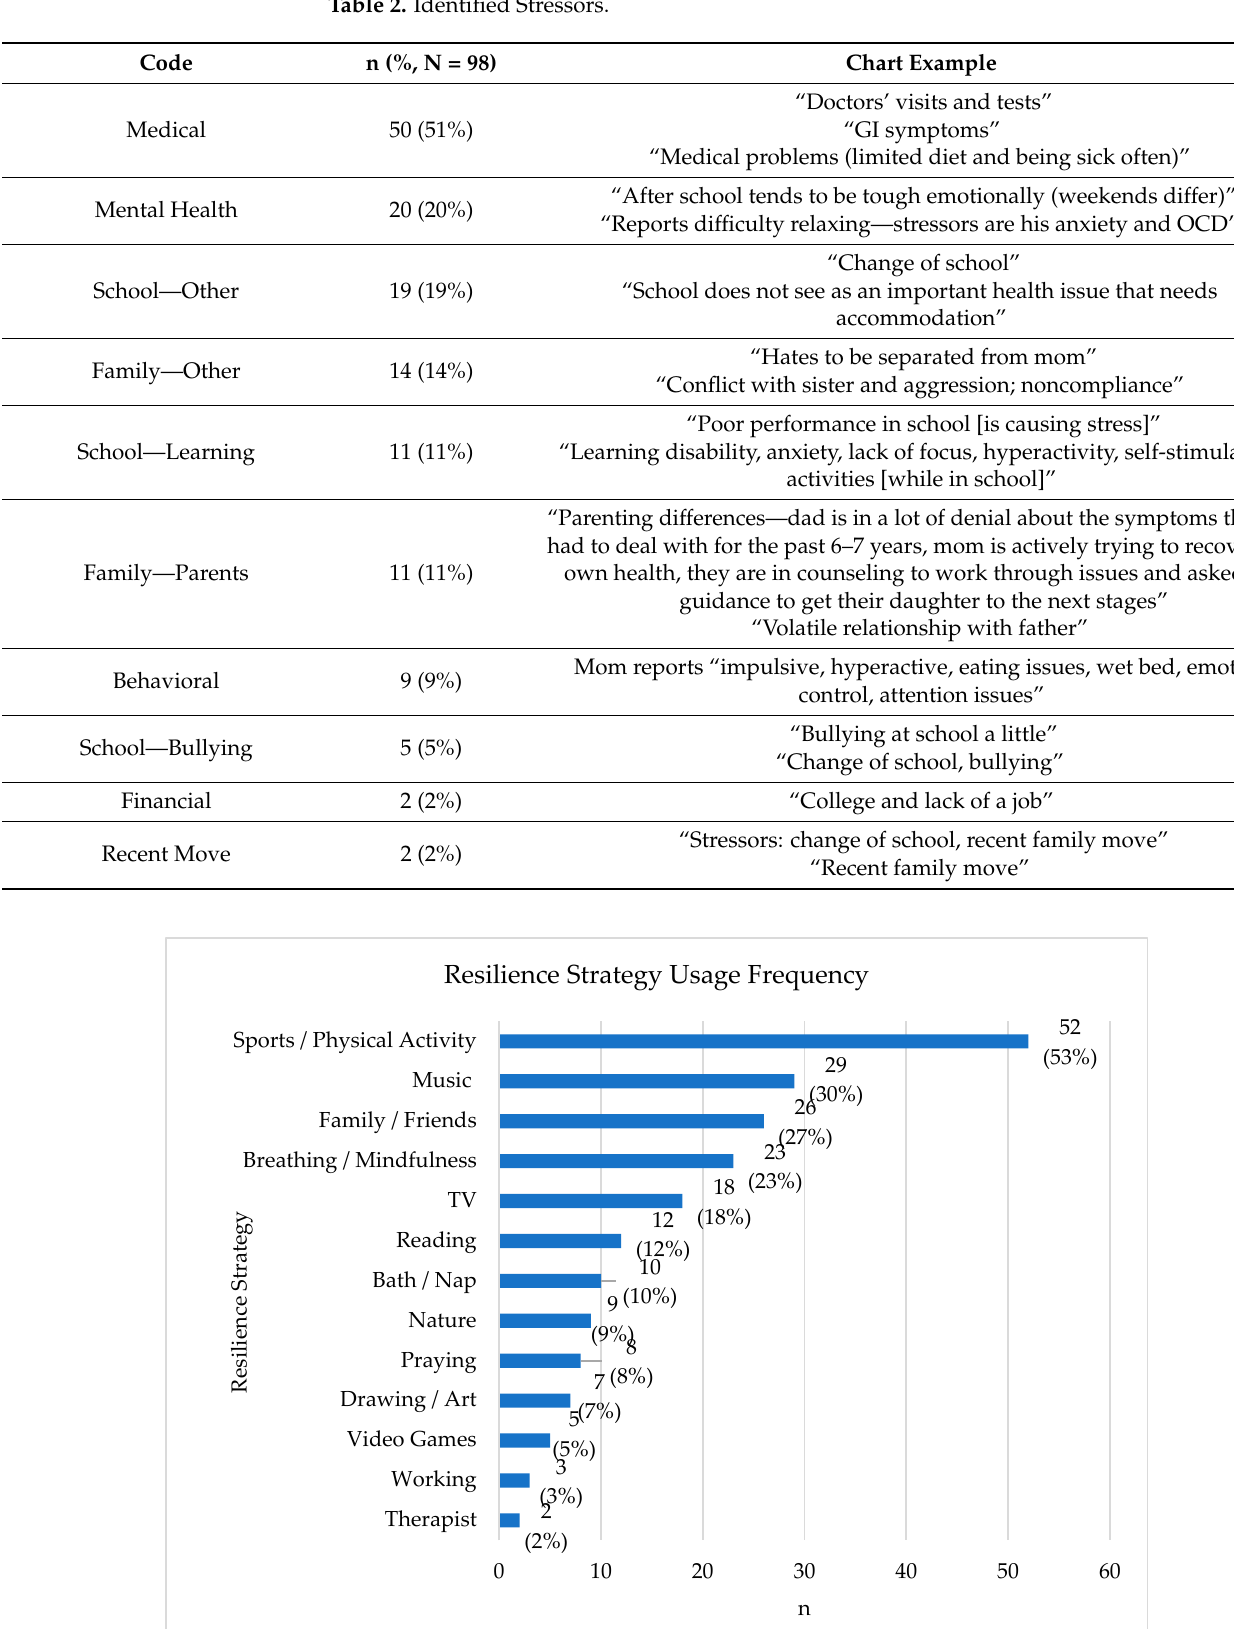
Table 2. Identified Stressors.